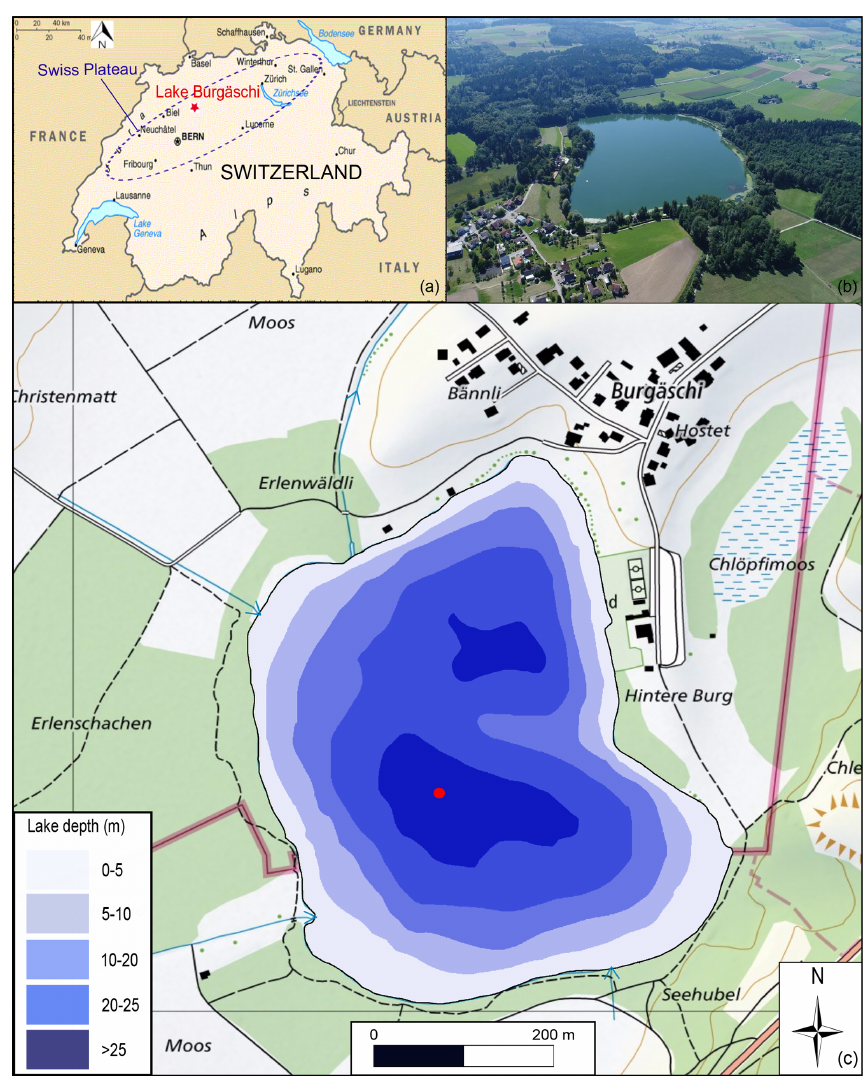
Figure 1. Study site. (a) Aerial map of Switzerland and the Swiss Plateau. Lake Burgäschi is indicated by the red asterisk. (b) Photo of Lake Burgäschi and catchment (© Google Maps 2018). (c) Bathymetric map of Lake Burgäschi adapted from Guthruf et al. (1999). The red dot indicates the coring site (color figure online). Green areas around the lake indicate forests, and white areas indicate agricultural land. Inflow and outflow to the lake are indicated by blue arrows (topographic maps: ©